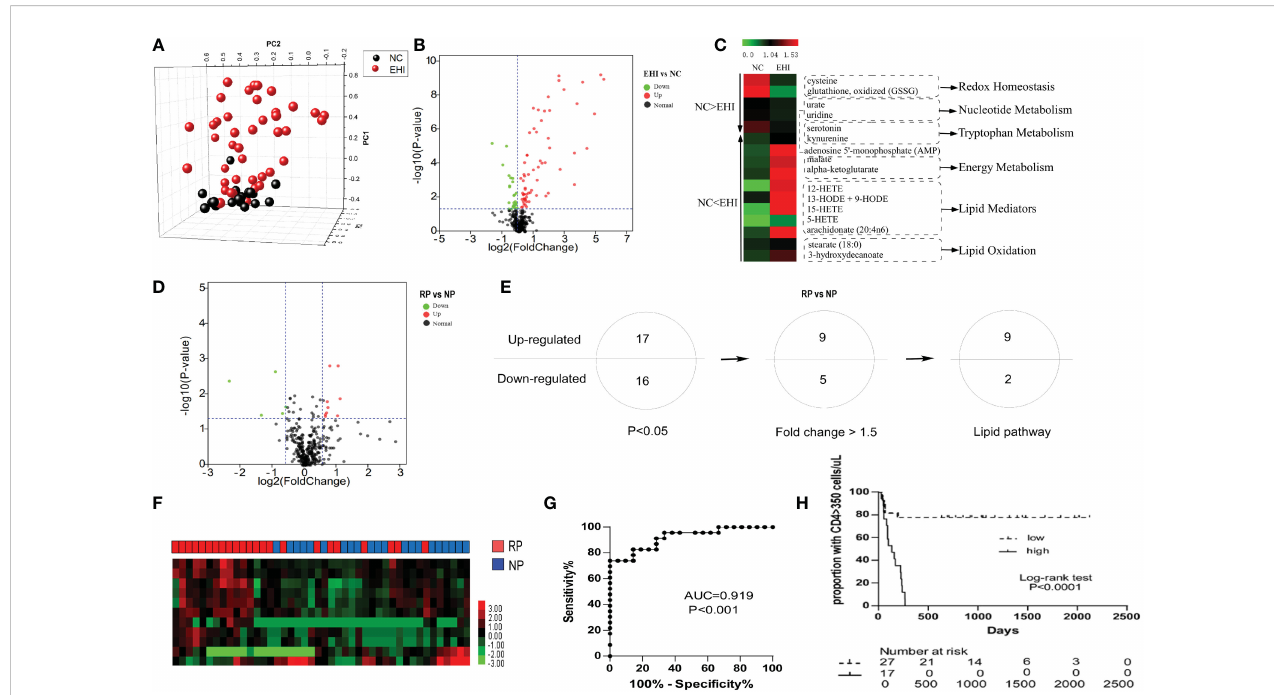
FIGURE 1 The metabolomic pro fi le of HIV-infected patients. (A) Principal component analysis (PCA; Origin 9.1) plot of 352 plasma metabolites from patients with early HIV infection (EHI, n = 44) at ~120 days of infection and HIV-negative controls (NCs, n = 20). The metabolomic pro fi le of the EHI group represented by these metabolites was distinct from that of NCs according to PCA. (B) Volcano plot of 352 plasma metabolites from EHIs and NCs. Ninety-one metabolites were signi fi cantly different between EHIs and NCs ( P < 0.05). (C) Pathways associated with redox homeostasis, nucleotide metabolism, tryptophan metabolism, energy metabolism, lipid mediators, and lipid oxidation, based on analyses of metabolites. (D) Volcano plot of 352 plasma metabolites from RPs and NPs. Thirty-three metabolites were signi fi cantly different between rapid progressors (RPs) and normal progressors (NPs; P < 0.05). (E) Thirty-three differentially expressed metabolites in RPs and NPs ( P < 0.05), including 14 metabolites with a fold-change > 1.5, were noted. Among them, 11 were lipid metabolites. (F) Heatmap demonstrating the 11-lipid metabolites that were differentially expressed between RPs and NPs by unsupervised hierarchical clustering. (G) Analyses of ROC curves revealed that the 11-lipid metabolite signature had a predictive accuracy of 91.9%, as measured by AUC, for rapid disease progression. (H) According to the Youden Index (high or low), high expression of the 11-lipid metabolite signature was highly predictive of disease